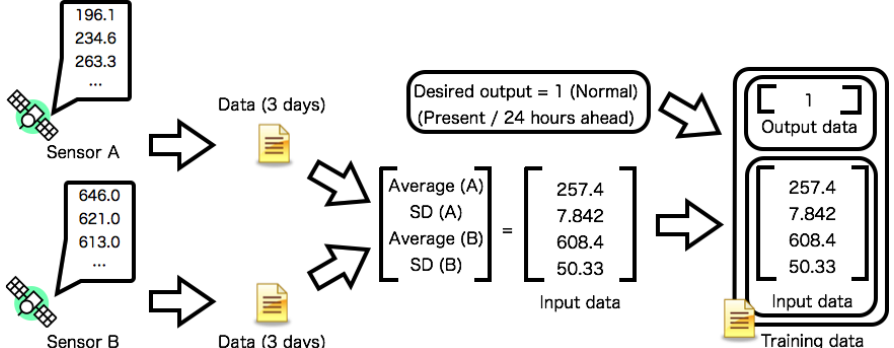
Figure 2. Training data generation process. Training data are created from observed data of two sensors on satellites. The training data consists of averaged values, the standard deviations, and the desired